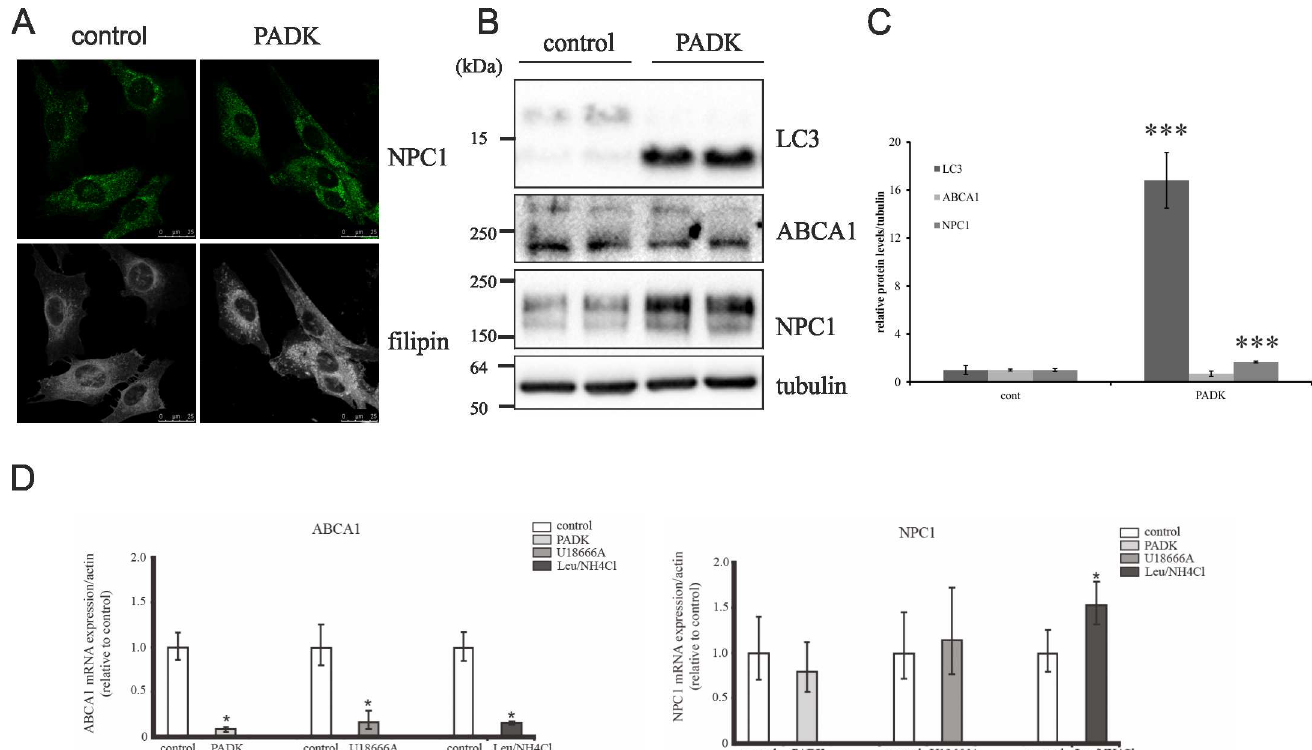
Fig 3. Cathepsin B/L inhibition causes NPC disease-like cholesterol accumulation in SH-SY5Y cells. (A) Confocalmicroscopy of SH-SY5Y control andPADK treated cells. Cholesterol(filipinstaining,white) and NPC1 (green). (B) Western blot of SH-SY5Y controland PADK treated cells using LC3, ABCA1 and NPC1 antibody. α -Tubulinwas used as a loadingcontrol. (C) Quantification of Western blot results of the 3 independentexperiments was performed by ImageJ. Student t-test was used for statistical analysis.Error bars presentthe mean ± standarddeviation( *** p < 0.001).(D) RT-PCR Expression of the cholesterol egress genesin the control, PADK, U18666A- andLeu/NH 4 Cl-treated SH-SY5Y cells, normalizedto β -actinand quantified by 2 −ΔΔ Ctmethodusingcontrolsampleas calibrator. ATP-BindingCassettesub-familyA member 1 (ABCA1) and Niemann-Pick C1 protein(NPC1) mRNA levelspresented as a fold change.The error bars present the mean ± SEM ( * p < 0.05).